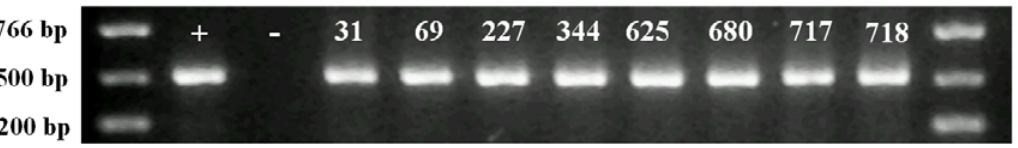
Figure 3. PCR screening of plantlets regenerated from hygromycin resistant T using gusA -specific primers. (+) positive control, plasmid DNA; ( − ) negative control, wild-type cv. Nipponbare DNA. Plant identification numbers 31, 69, 227, 344, 625, 680, 717, and 718 show PCR products consistent with the expected 494 bp control fragment. PCR products were separated on a 1.2% agarose gel.